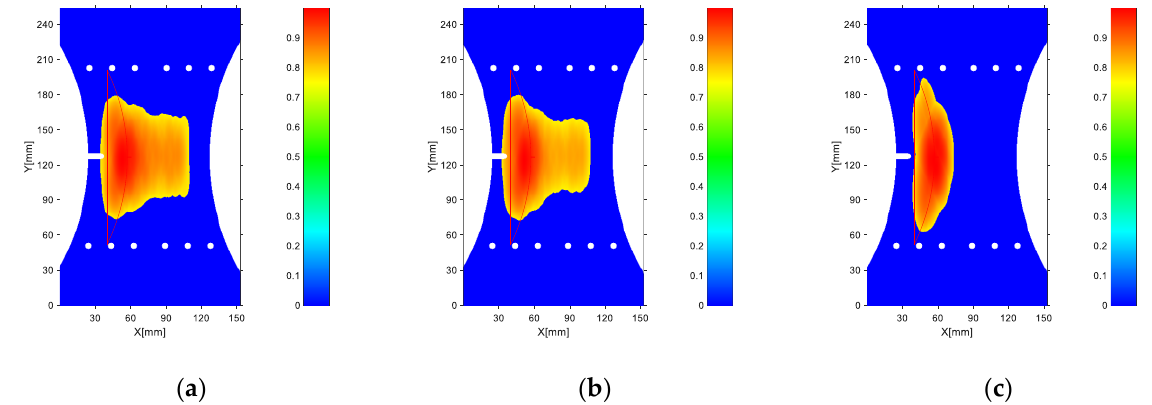
Figure 16. Thresholded imags for different damage factors at 80,000 fatigue cycles: ( a ) energy damage factor; ( b ) cross-correlation damage factor; ( c ) sparse representation damage factor.